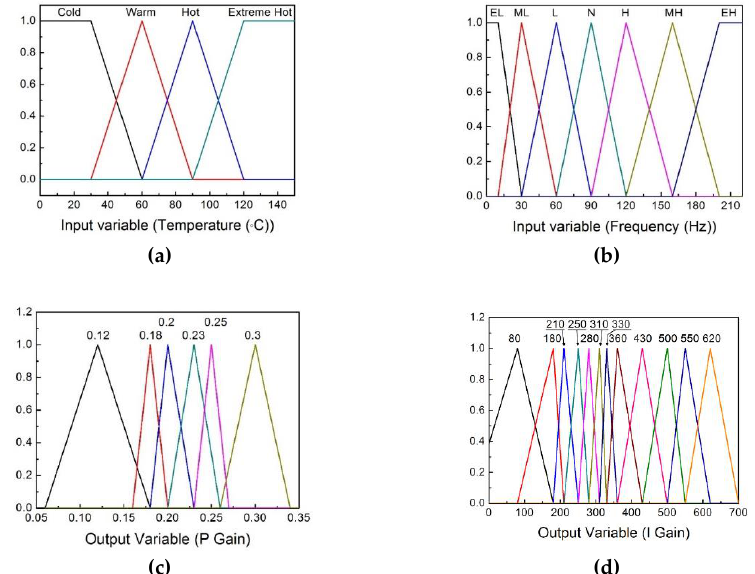
Figure 8. Schematic of the fuzzy PID(proportional-integral-derivative) controller.